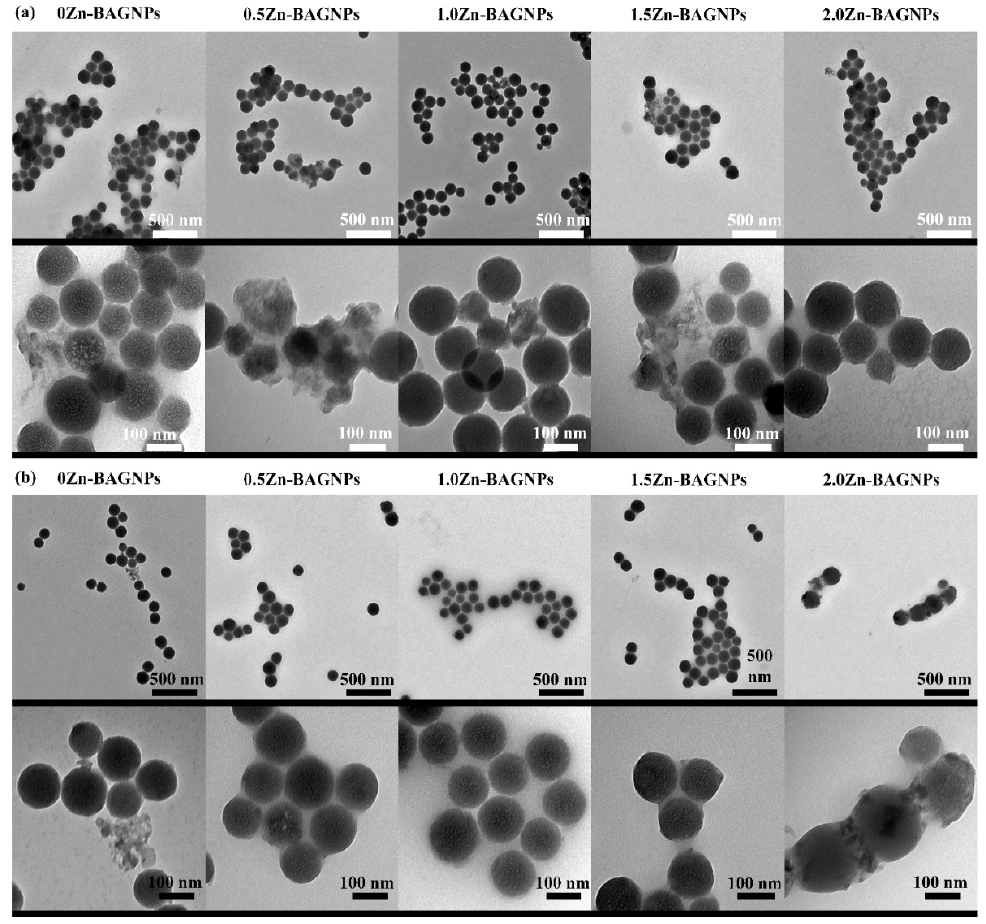
Figure 7. TEM micrographs of Zn-BAGNPs after incubation in ( a ) SBF pH7.4 and ( b ) PBS pH7.4 for 21 days (operating at 100 kV). Scale bars = 500 nm ( upper row ) and 100 nm ( lower row ).